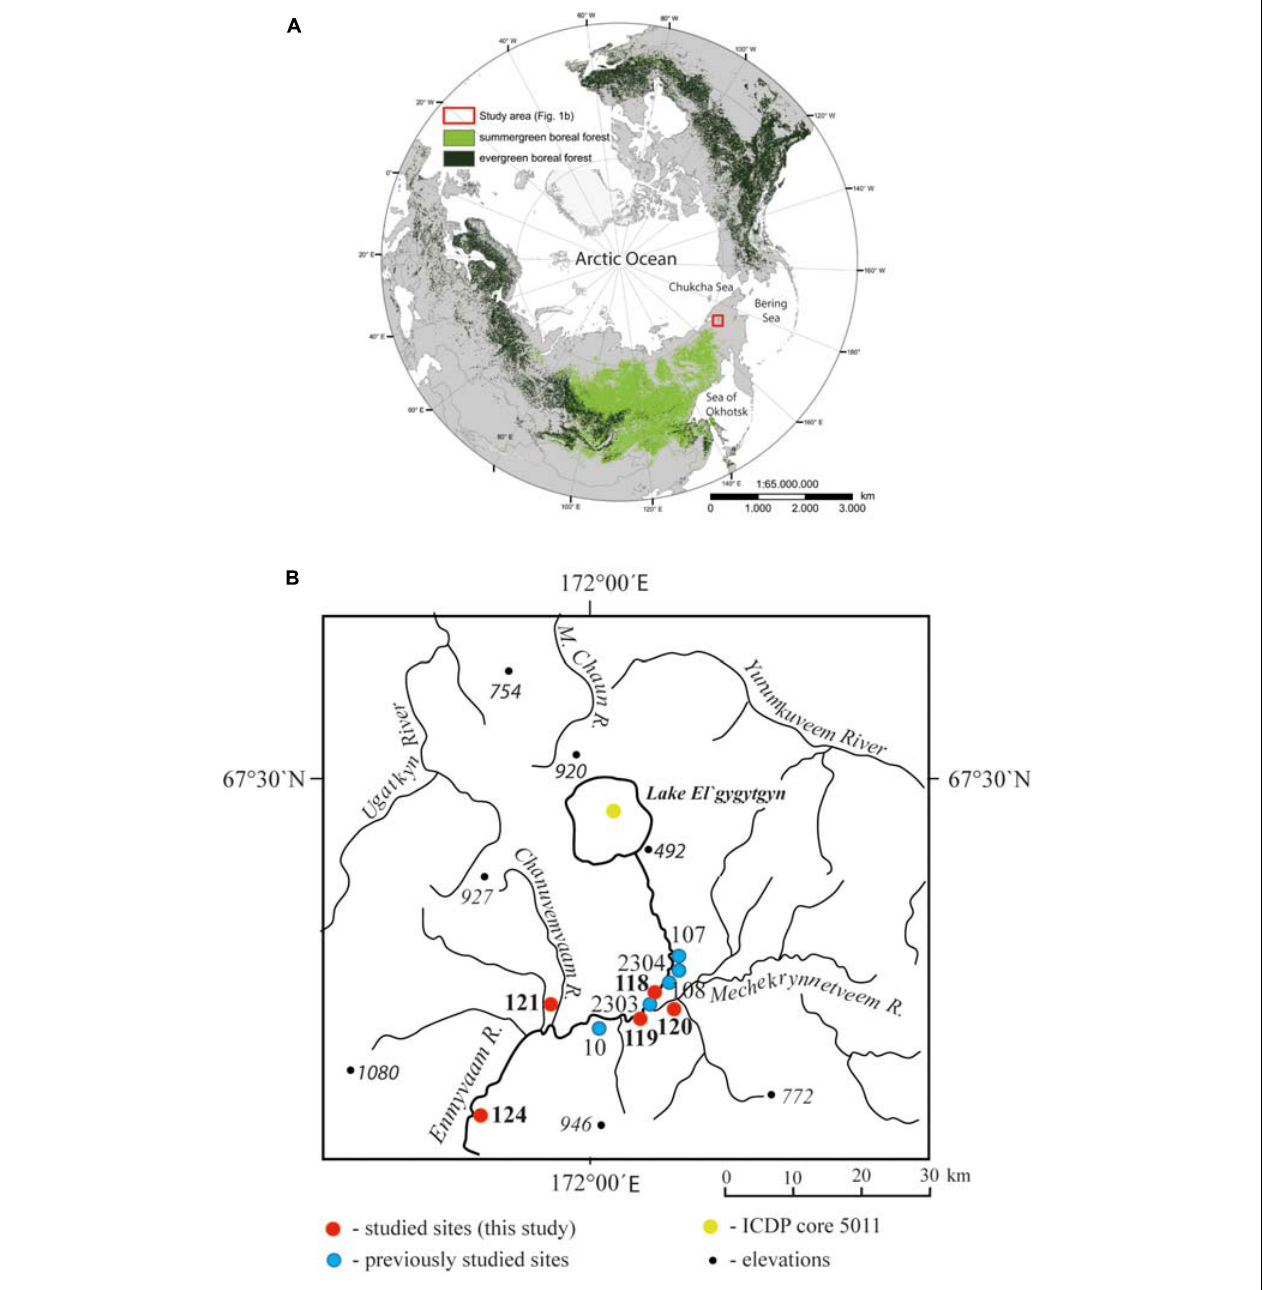
FIGURE 1 | (A ) Polar view on the high northern latitudes with the distribution of summergreen and evergreen boreal forests and the location of study area in northeastern Siberia. (B) Locations of fluvial sediment sections studied in the vicinity of Lake El’gygytgyn and of ICDP Site 5011-1 in the lake center.